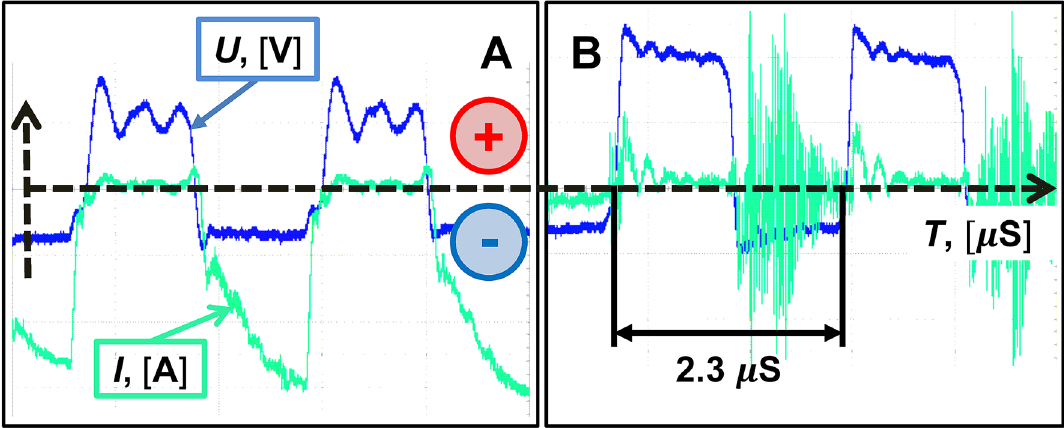
Figure 5. The voltage (blue curve) and current flowing through the plasma (green curve) in operating mode are shown. The steady-state plasma burning mode ( A ); the unsteady plasma burning mode ( B